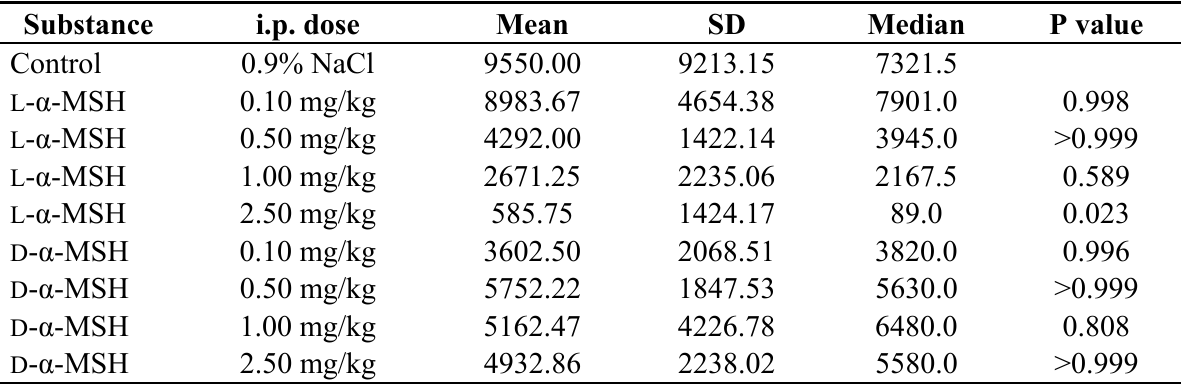
Table 2. Alanine aminotransferase activity (U/L) in plasma of the control and α -MSH treated animals 24 h after acetaminophen administration.